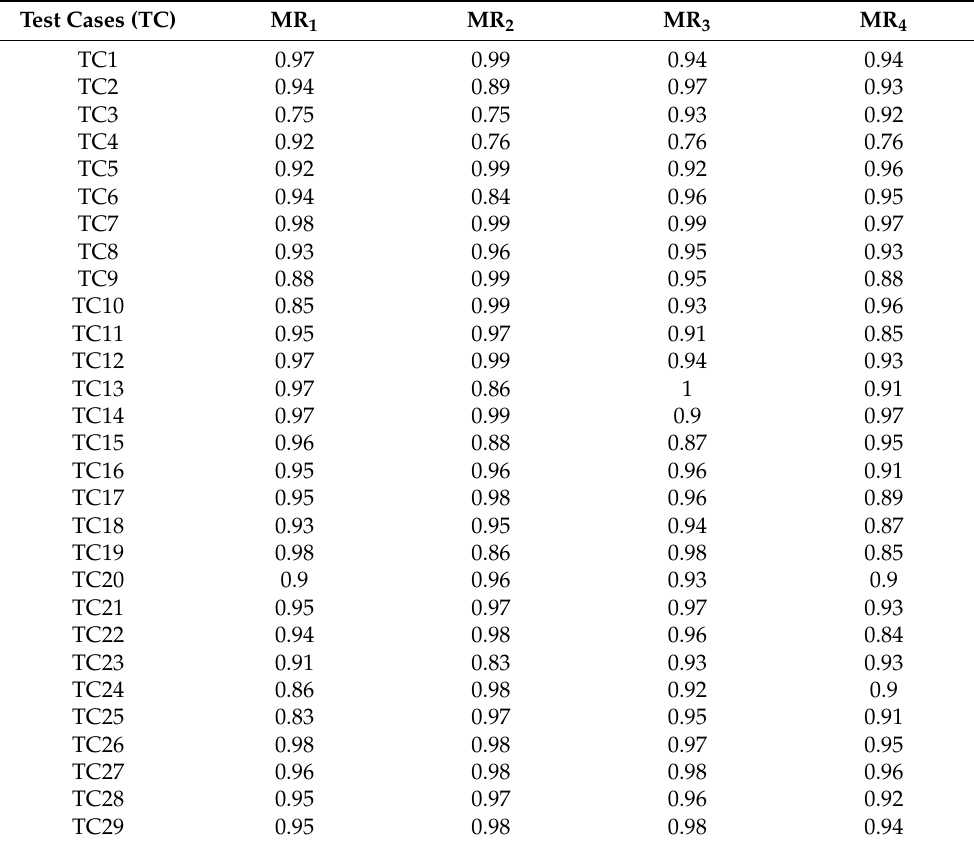
Table 6. SSIM value of T2-weighted